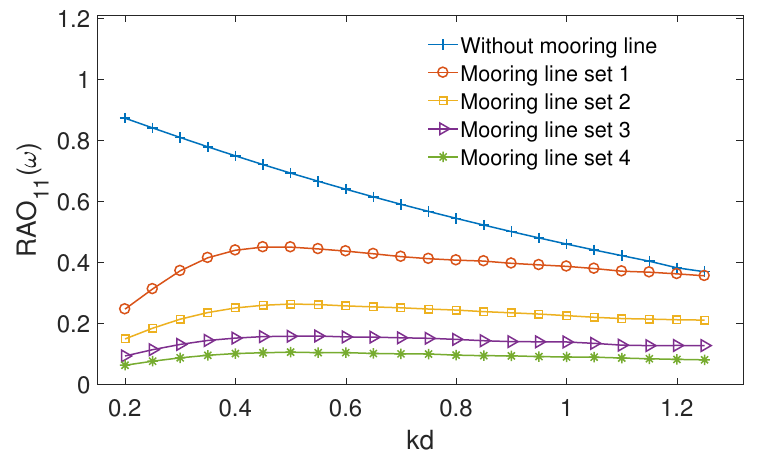
Figure 10. Comparison of the floating body surge motion RAO 11 ( ω ) between without mooring line condition, mooring line set 1, mooring line set 2, mooring line set 3 and mooring line set